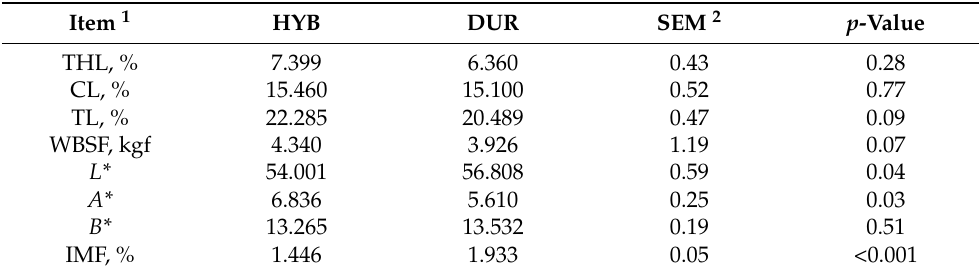
Table 8. Pork quality parameters evaluated on LD of pigs of different genetic lines.